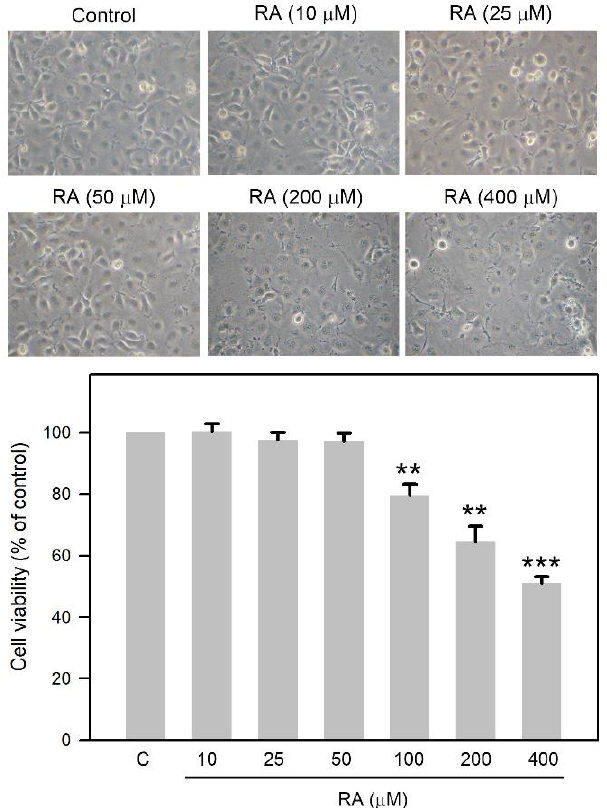
Figure 1. Effects of rosmarinic acid (RA) on the cell viability and morphology of A7r5 cells. Rat A7r5 aortic smooth muscle cell was treated with serial concentrations (0–400 µ M) of RA for 24 h and then the resulting cell viability and cell morphology were assessed using SRB assay and light microscopy at 200 × , respectively. Data are presented as mean ± SD. Three independent experiments were performed for statistical analysis: ** and ***, p < 0.01 and p < 0.005 as compared to the